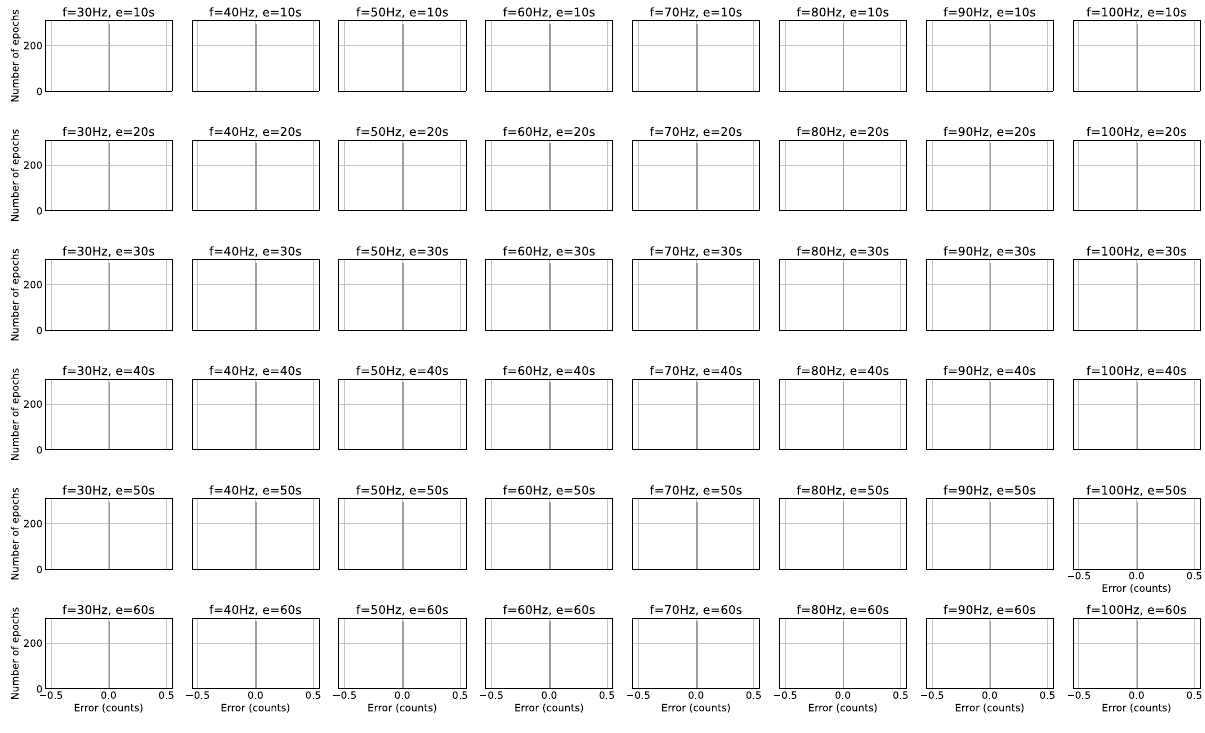
Figure 4. Comparison of counts generated by our python code and those generated by CenterPoint. Each plot corresponds to a combination of data sampling rate and epoch length. From top to bottom, epoch length goes from 10 to 60 s. From left to right, sampling frequency goes from 30 to 100 Hz. In all cases, the counts are identical between the two